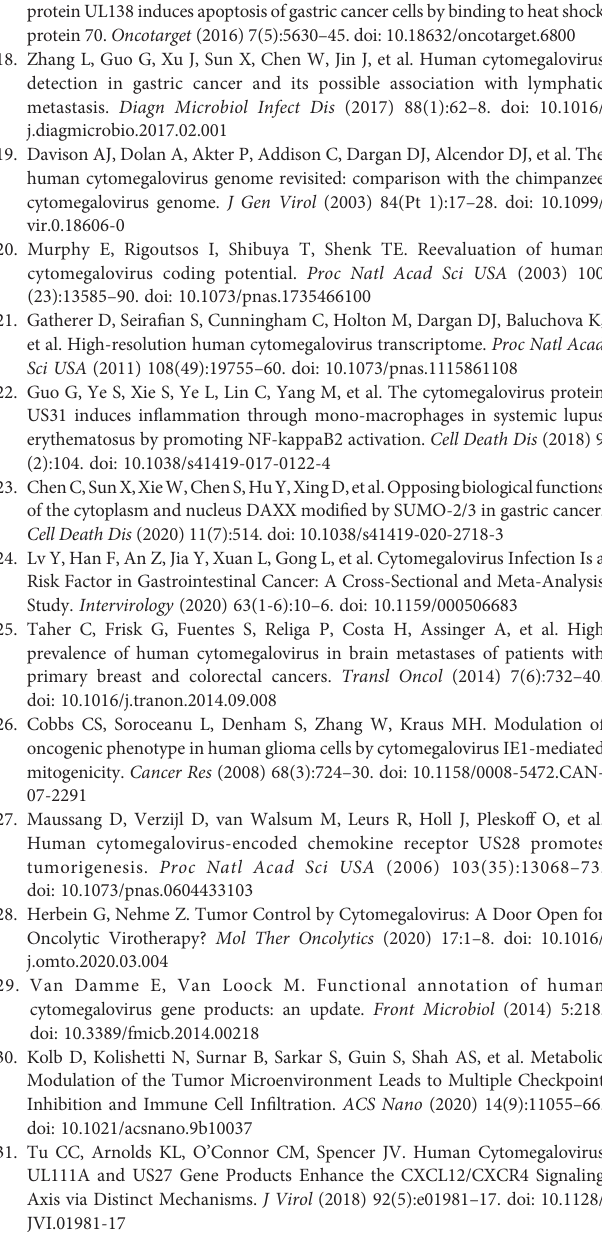
Supplementary Table 3 | Enrichment list of US31 interacting proteins in